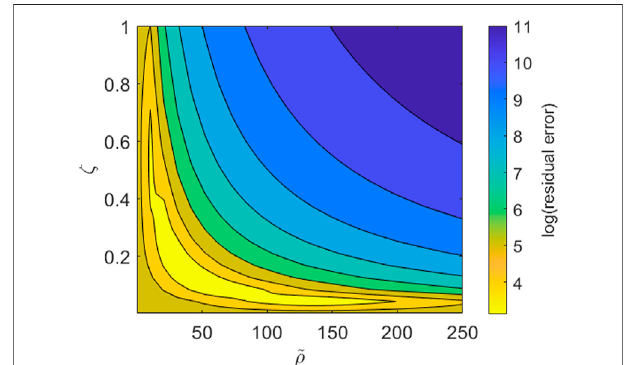
FIGURE 6 | Contour plot for the parameter subspace of the pool size of PBMCs, ~ ρ ∈ [ 0 , 250 ] , and the cytokine out fl ux rate, ζ ∈ [0, 1]. The contours representthequalityof fi ttothedatashownin Figure5 asgivenbythesumof squares residual error and is shown on a log scale. All other model parameters are fi xed to those used for the simulation in Figure 5